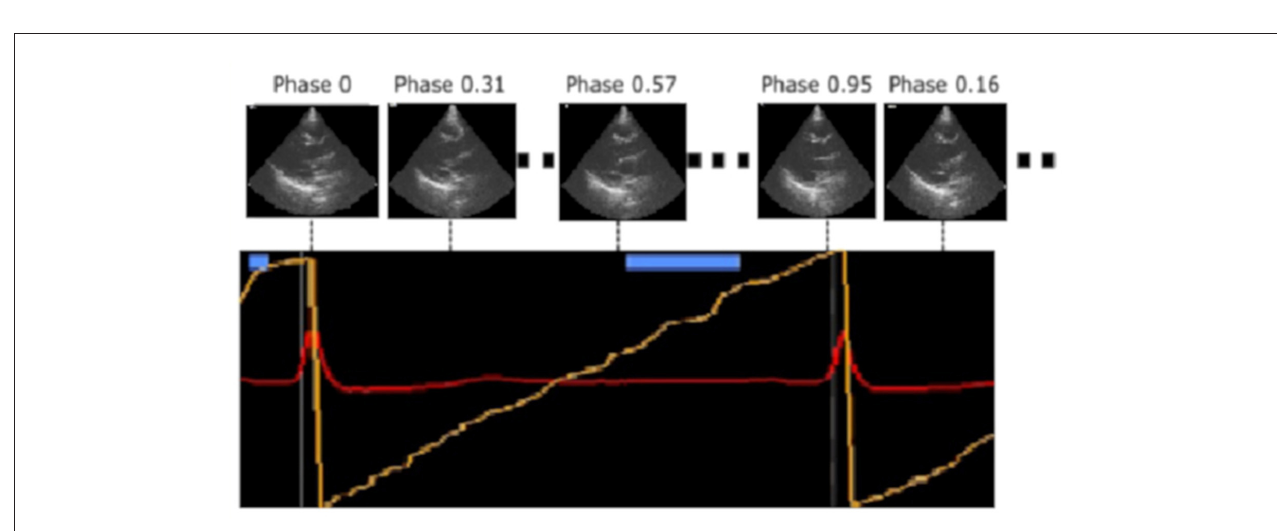
FIGURE 2 | Scheme representing of the acquisition system flow.